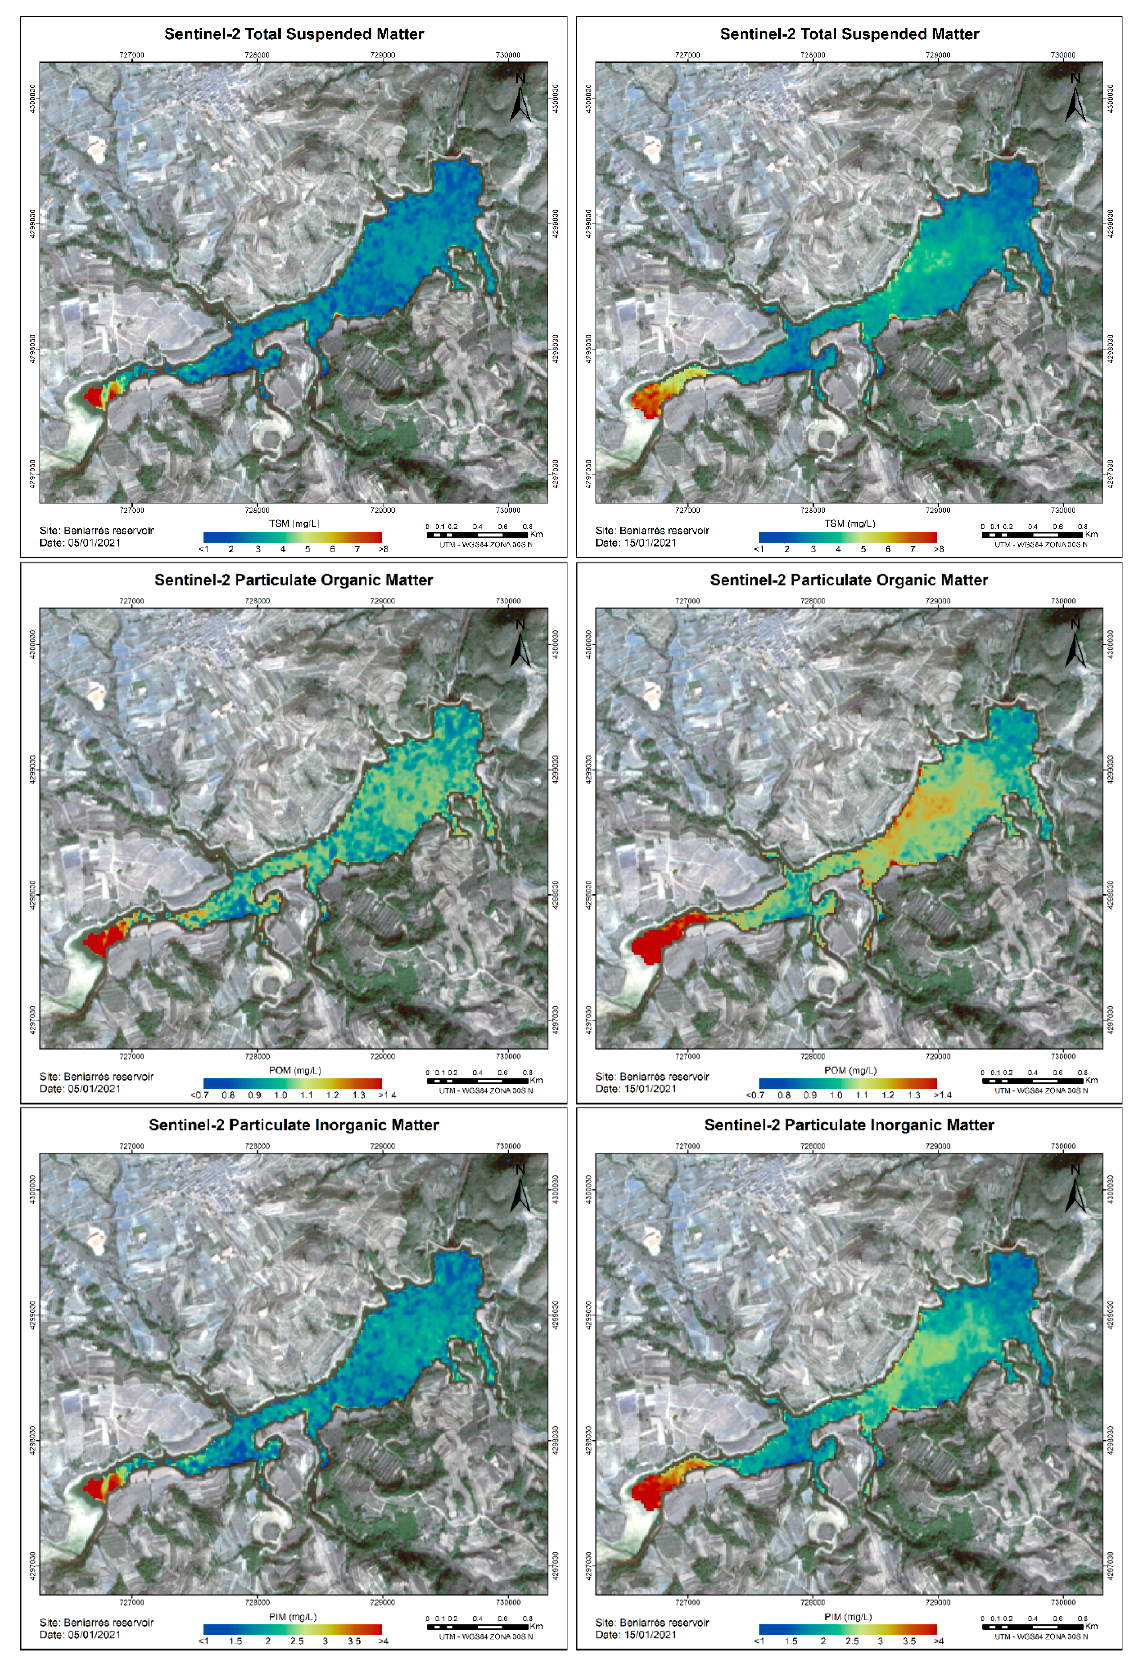
Figure 13. Beniarrés reservoir thematic maps for the three variables studied. Note different scales for POM and PIM.